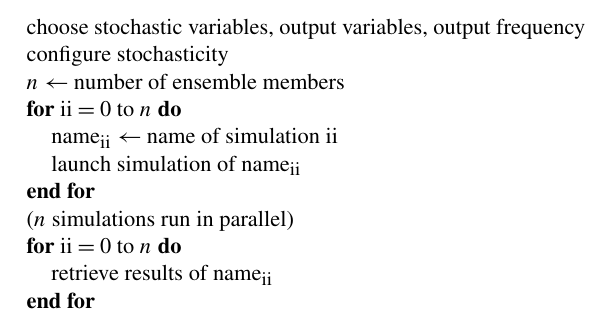
Algorithm 1 Parallelization procedure for ensemble